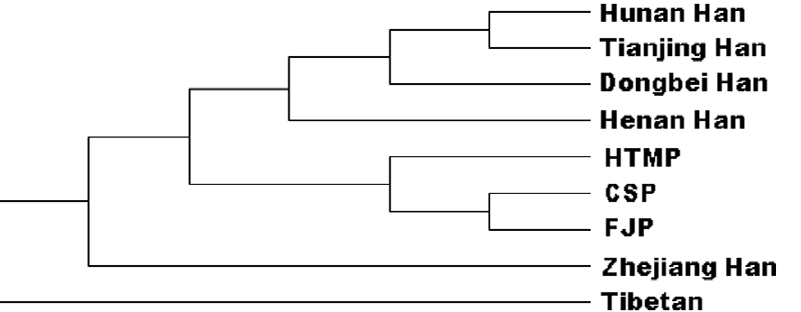
Figure 6. A neighbor-joining tree of Chinese populations based on Y-STR data. This unrooted tree was constructed by use of genetic distances between populations. Shows that the EC high-risk Chaoshan is extremely close to the EC high-risk FJP and that the 2 are clustered with the EC high-risk HTMP. Hunan, Tianjing, Dongbei, and Henan Hans are grouped in the upper part of the tree. doi:10.1371/journal.pone.0011118.g006 PLoS ONE |